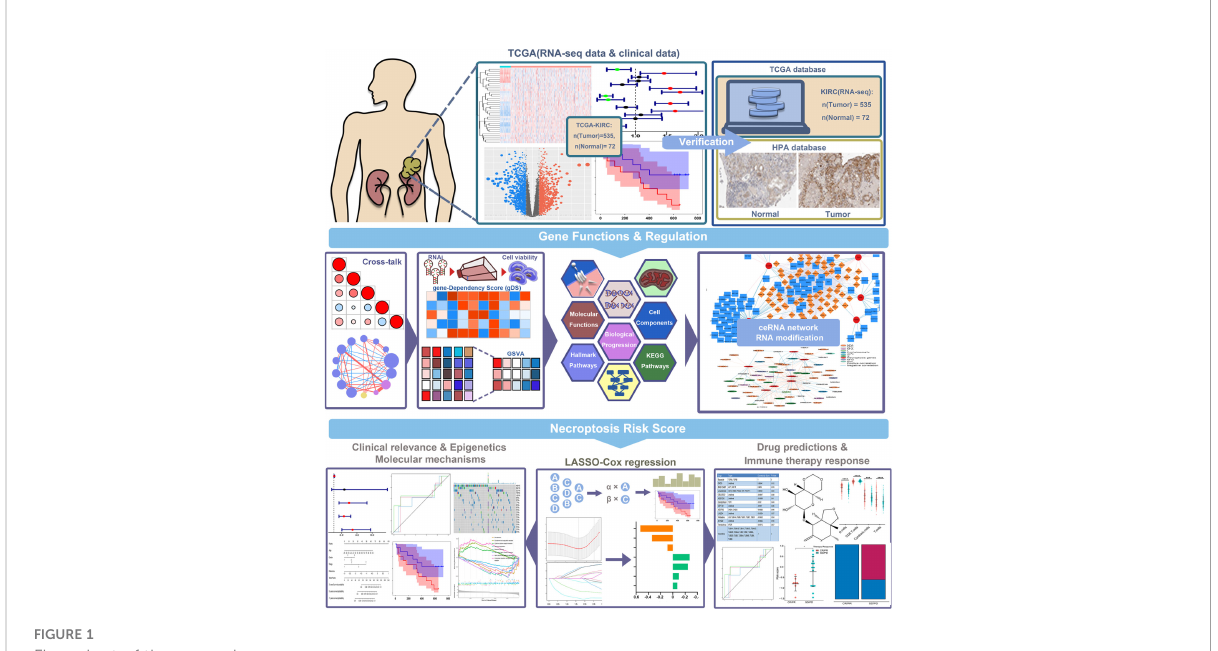
FIGURE 1 Flow chart of the